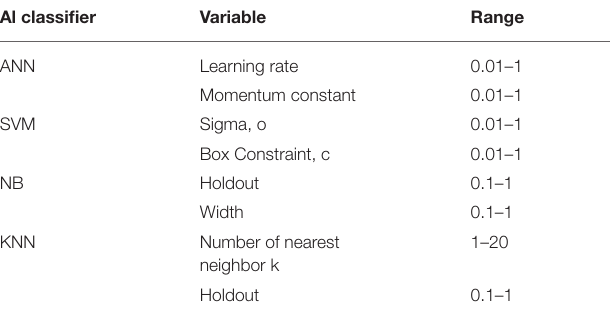
TABLE 1 | Variables for each Al classifier used for SPBOA